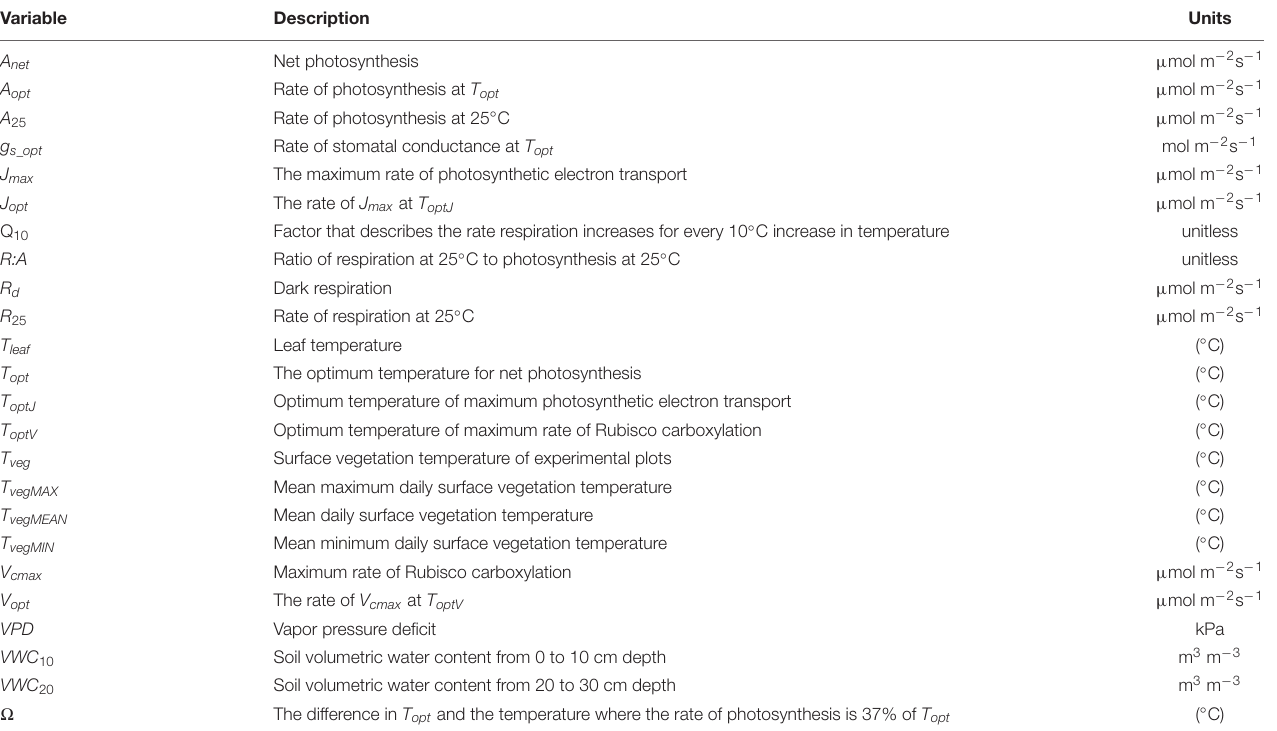
TABLE 1 | Abbreviations and descriptions. Variable